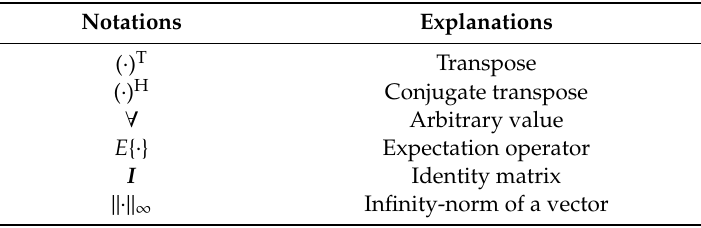
Table 1. Mathematical